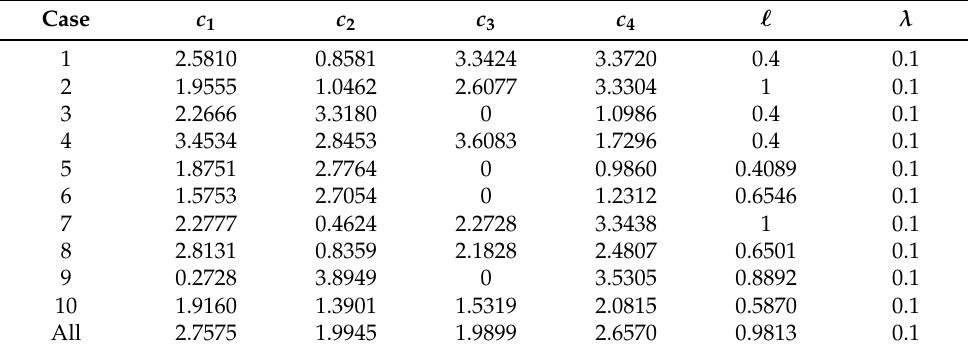
Table A3. Hyper-parameter optimization using RBF ( (cid:96) = 0.4 ) as